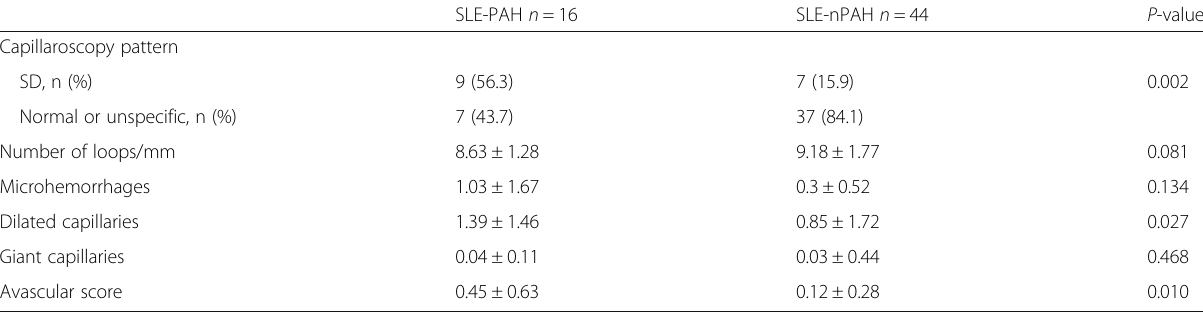
Table 2 Abnormalities on nailfold capillaroscopy among patients with SLE associated with PAH (SLE-PAH) or not associated with PAH (SLE-nPAH) SLE-PAH n = 16